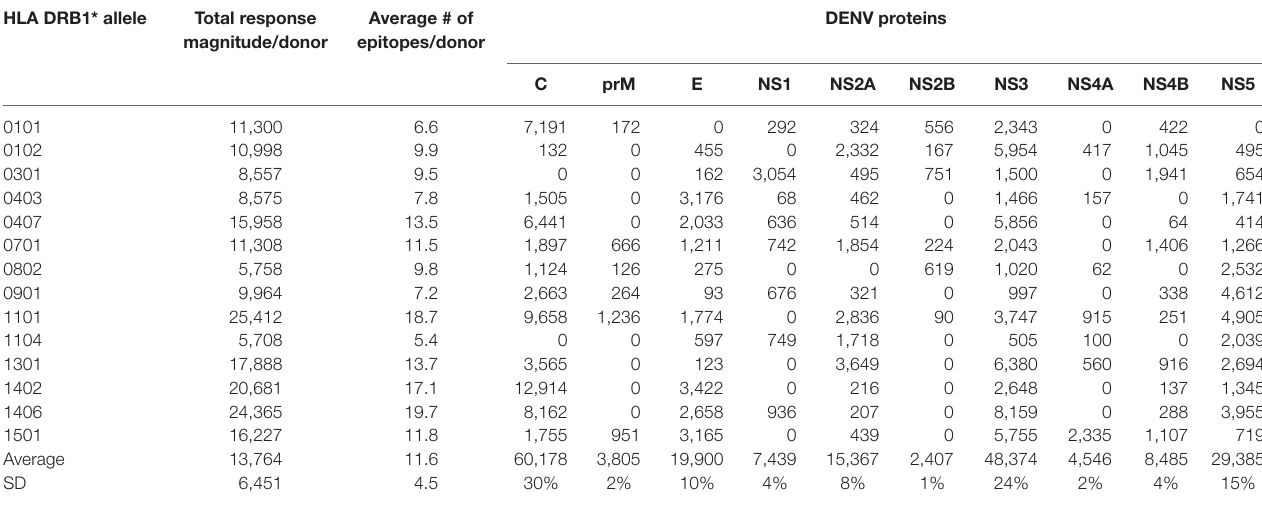
TaBle 1 | CD4 + T cell dengue virus (DENV) immunoreactivity in peripheral blood mononuclear cells from the Nicaraguan cohort studied. hla DrB1* allele Total response